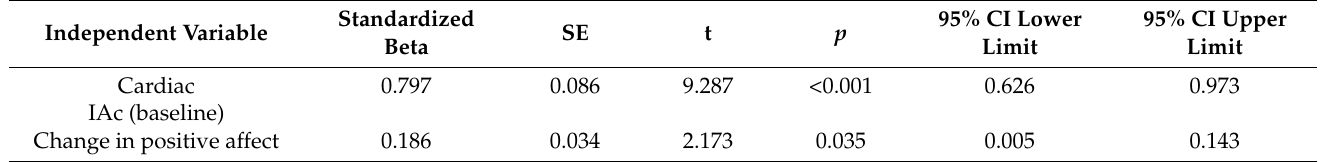
Table 3. Model summary of the final regression model.